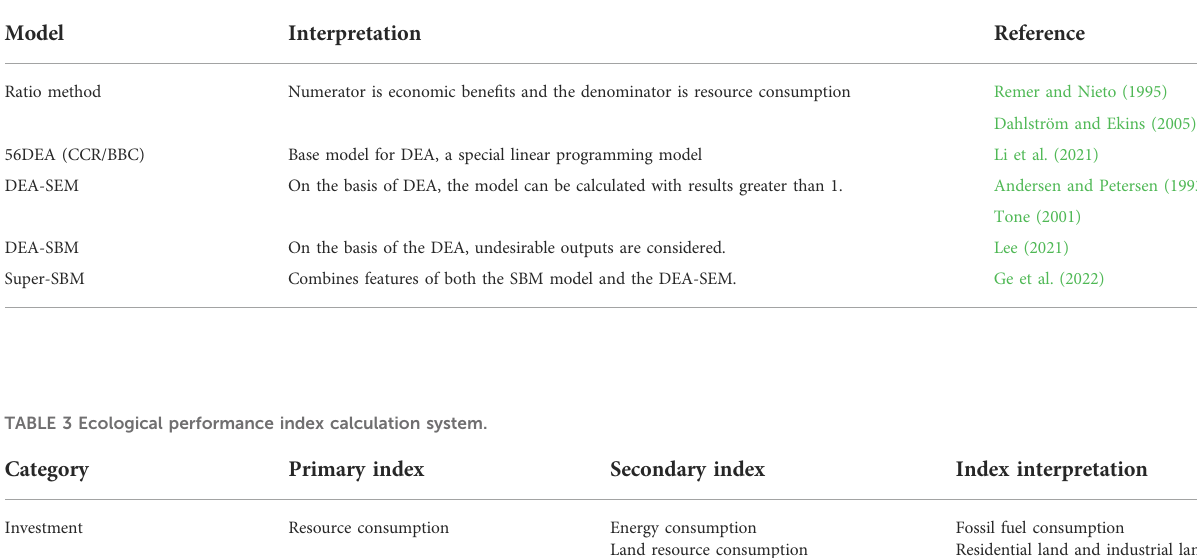
TABLE 2 Relevant measurement methods of ecological performance.